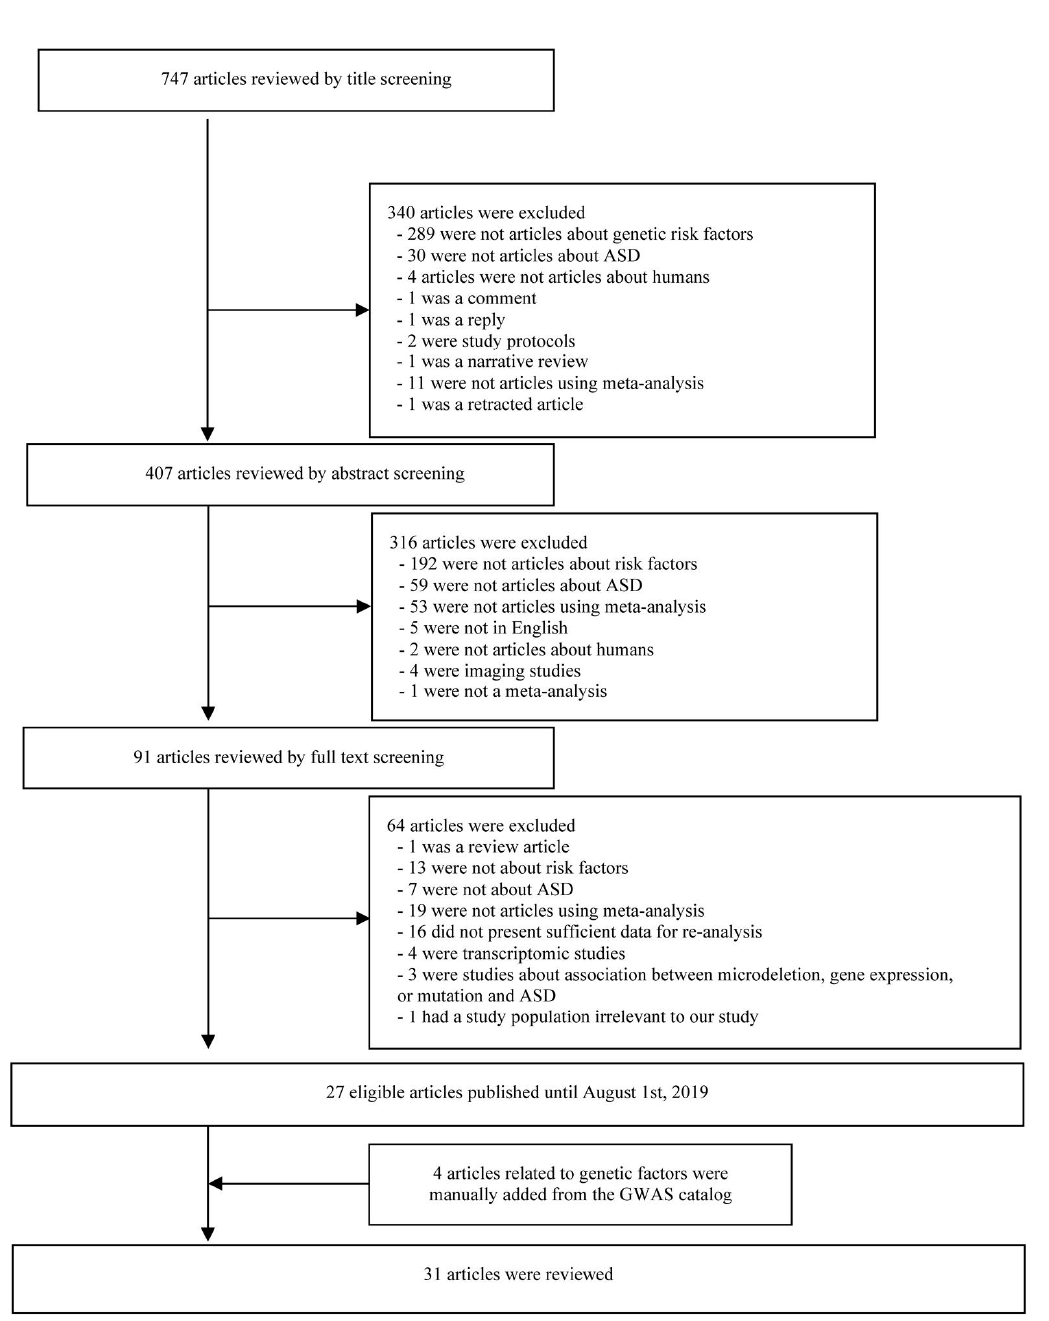
Figure 1. Flow chart of literature search.